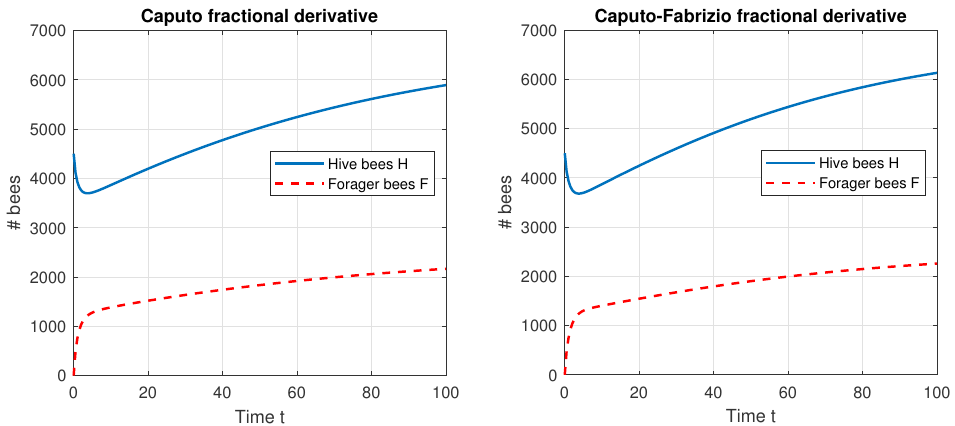
Figure 3. The colony population size for H 0 = 4500, F 0 = 0 and r = q = 0.95, modeled by the Caputo (3a)–(3c) ( left ) and Caputo–Fabrizio derivatives (4) ( right ).